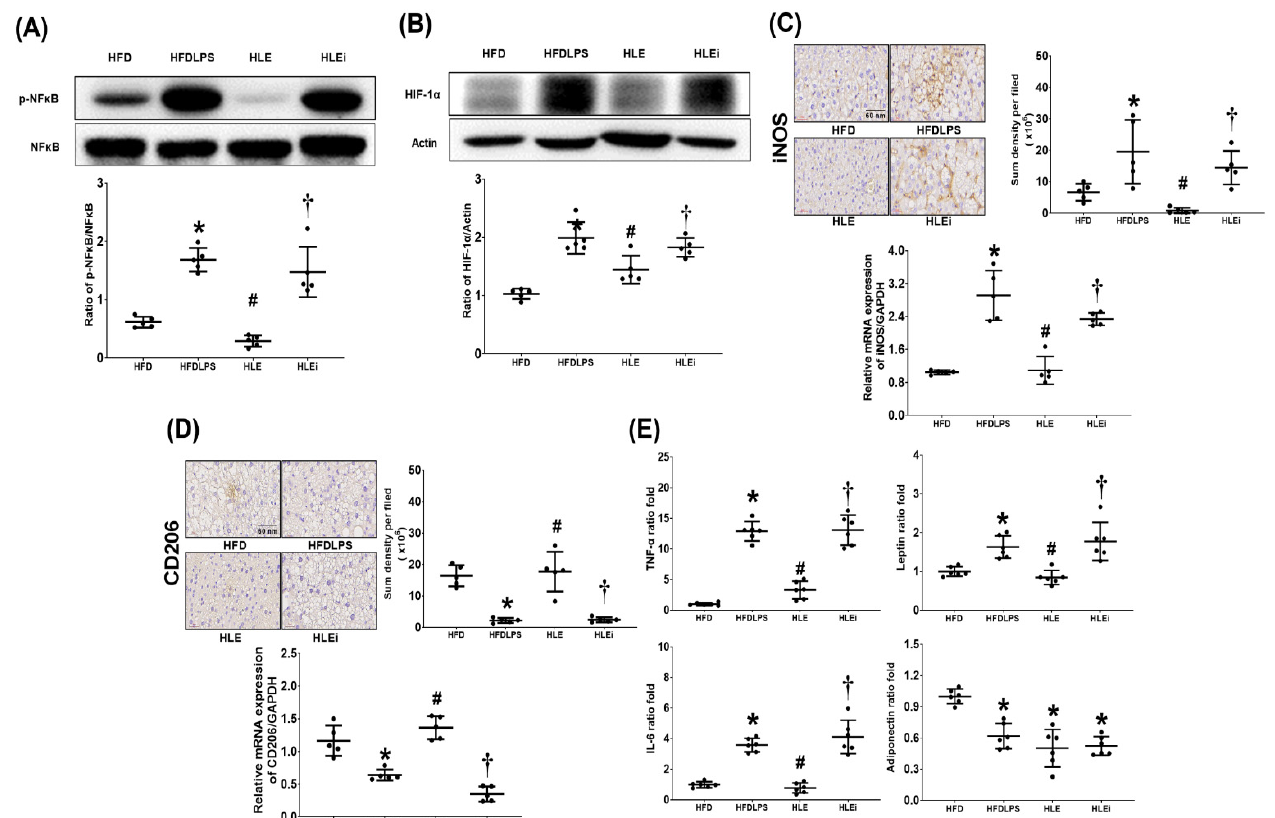
Figure 4. ( A ) Representative gel photographs of nuclear factor- κ B (NF- κ B) and phosphorylated NF- κ B (p-NF- κ B) in liver tissues analyzed using an immunoblotting assay and the relative band density of p-NF- κ B/NF- κ B in liver tissues, using an immunoblotting assay. Data were obtained from 5 mice in each group. ( B ) Representative gel photographs of hypoxia-inducible factor-1 α (HIF-1 α ) and actin (the internal standard) in liver tissues analyzed using an immunoblotting assay and the relative band density of HIF-1 α /actin in liver tissues, using an immunoblotting assay.